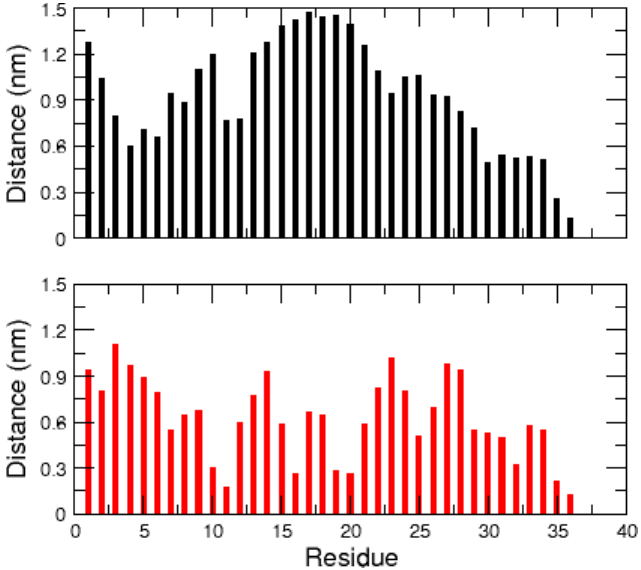
Figure 5. Average distances between the C-terminal residue Tyr37 and all other amino acids of the amidated ( top ) and non-amidated ( bottom ) hIAPP